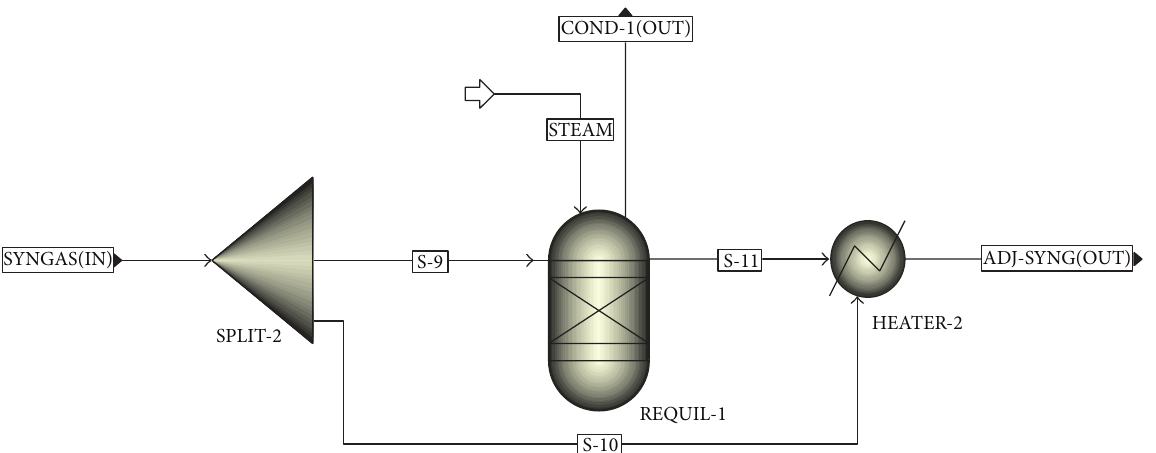
Figure 7: Aspen Plus SHIFTING hierarchy diagram to simulate the WGSR stage in the coal-SNG